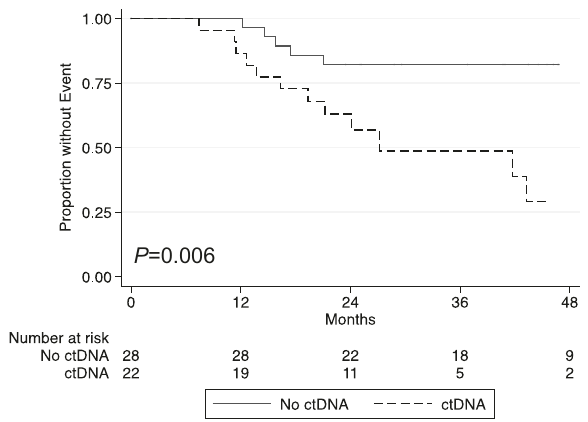
Fig. 3 Prognostic signi fi cance of circulating tumor DNA (ctDNA) in Ewing sarcoma. Here we show that detectable ctDNA at diagnosis is associated with poor outcomes among patients with localized Ewing sarcoma. Adapted with permission from Shulman DS. et al., BJC , 2018 80